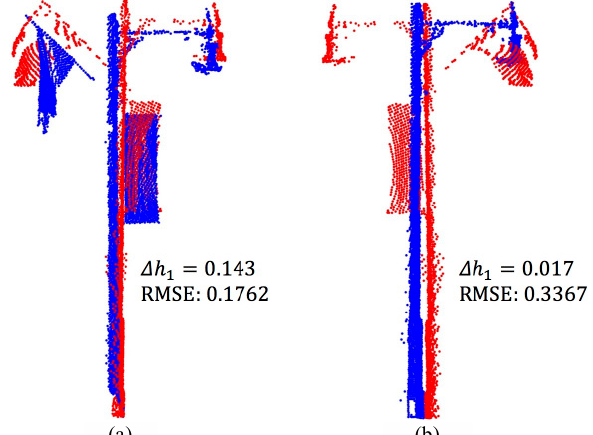
Figure 19. Registration differences between the same pole and different templates. ( a ) Complex street lamp as template; ( b ) Simple street lamp as template.